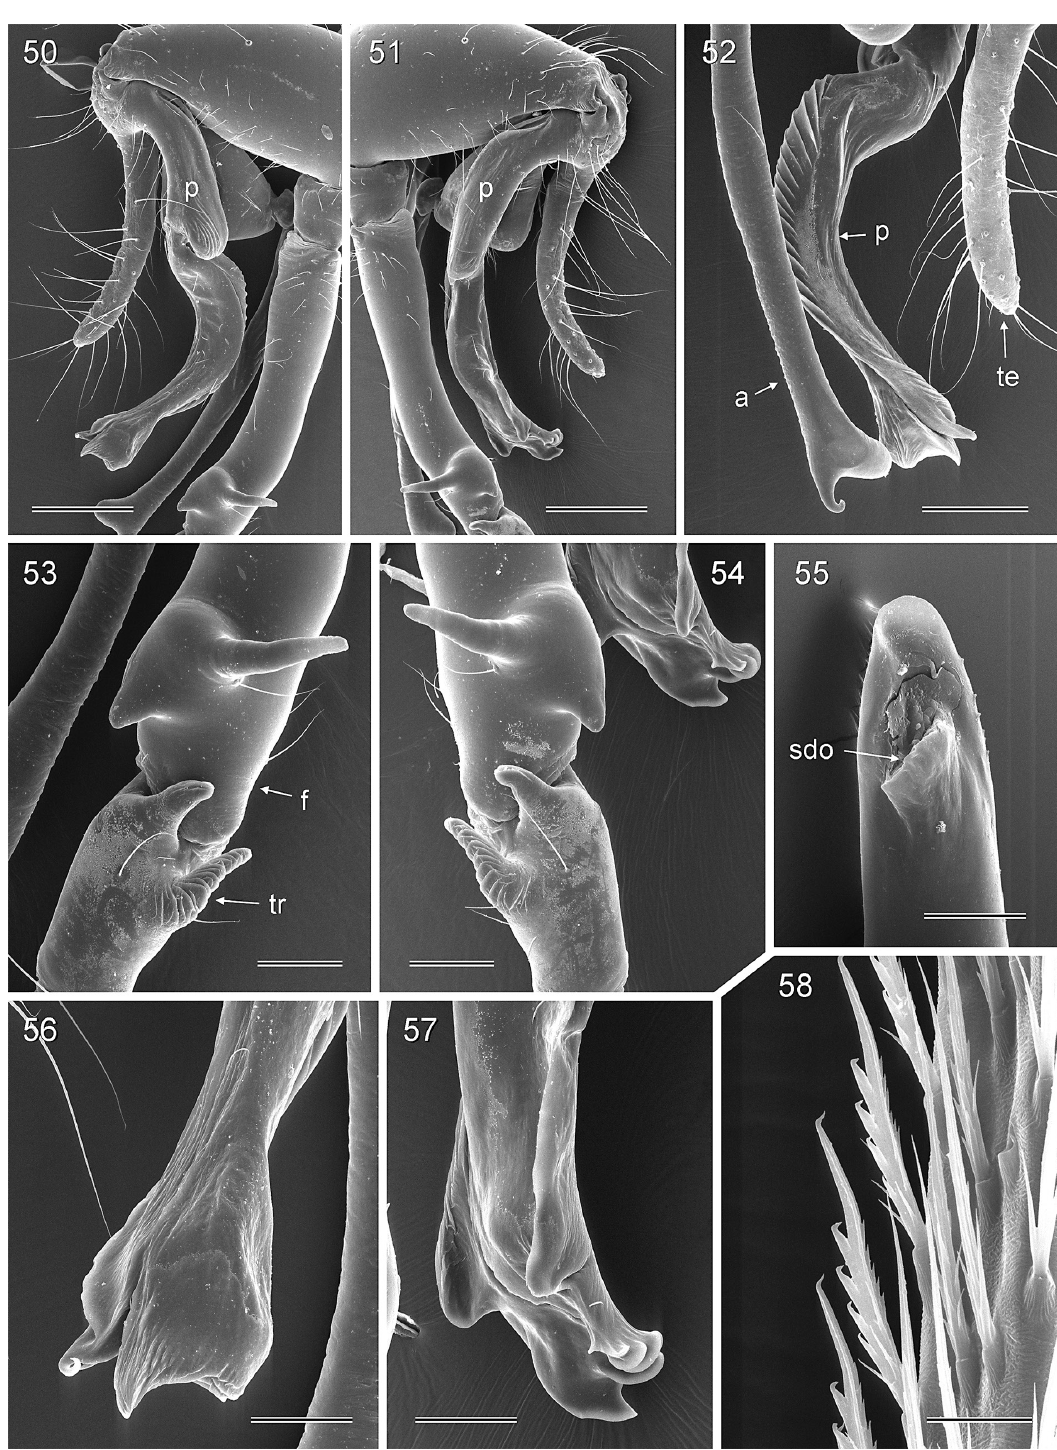
Figs 50–58. Panjange camiguin Huber sp. nov., SEM micrographs (ZFMK, Ar 13003, 13004). 50– 51 . Left and right male palps, retrolateral views. 52 . Left procursus and appendix, prolateral view. 53– 54 . Left and right male palpal trochanters and femora proximally, retrolateral views. 55 . Tip of embolus. 56–57 . Left and right procursus tips, retrolateral views. 58 . Comb-hairs on female tarsus 4. Abbreviations: a = appendix; f = femur; p = procursus; sdo = sperm duct opening; te = tarsal elongation; tr = trochanter. Scale bars: 50–51 = 300 µm; 52 = 200 µm; 53–54 = 100 µm; 55 = 30 µm; 56–57 = 80 µm; 58 = 20